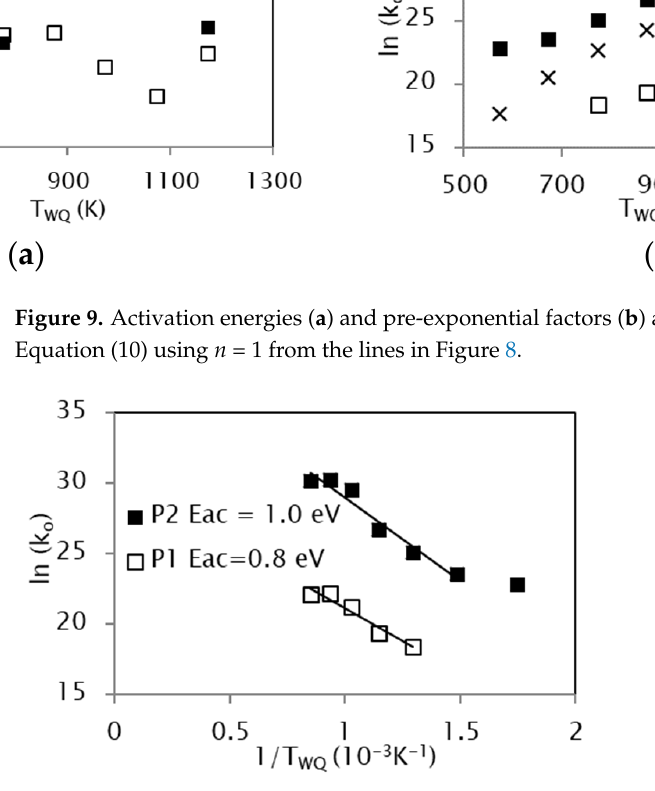
Figure 10. ln( k o ) vs. 1/ T WQ plots for P 1 and P 2 , and activation energies calculated from the slopes.